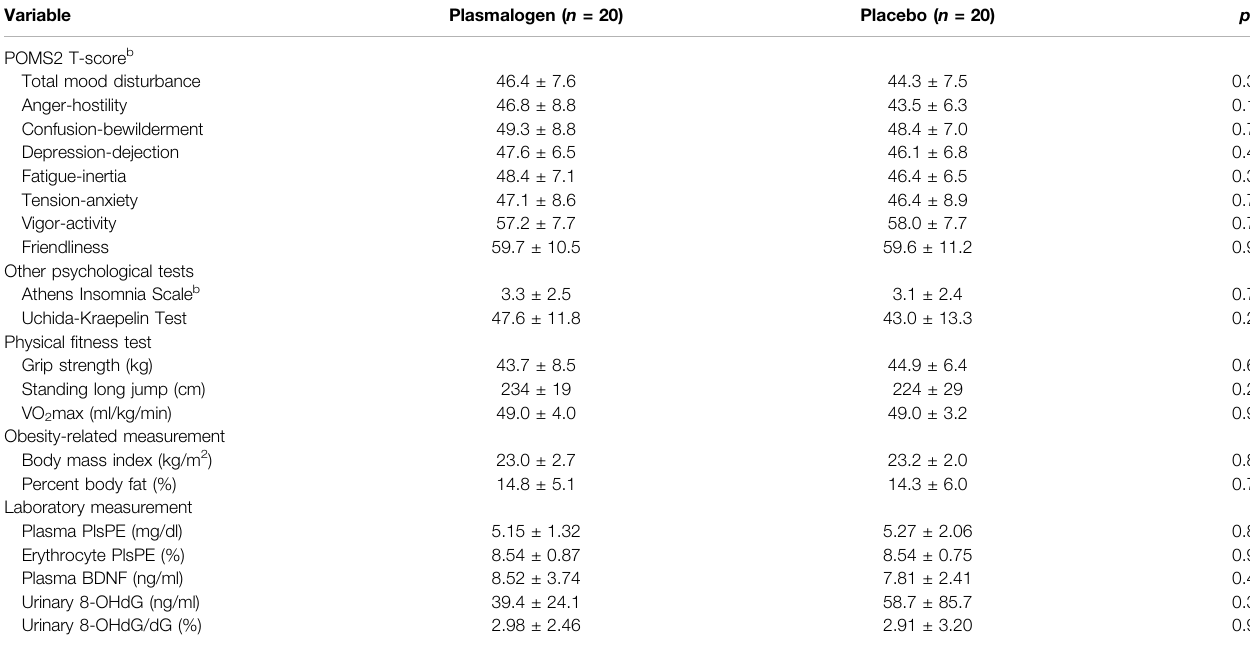
TABLE 3 | Primary and secondary outcomes at baseline lightfaced (means ±